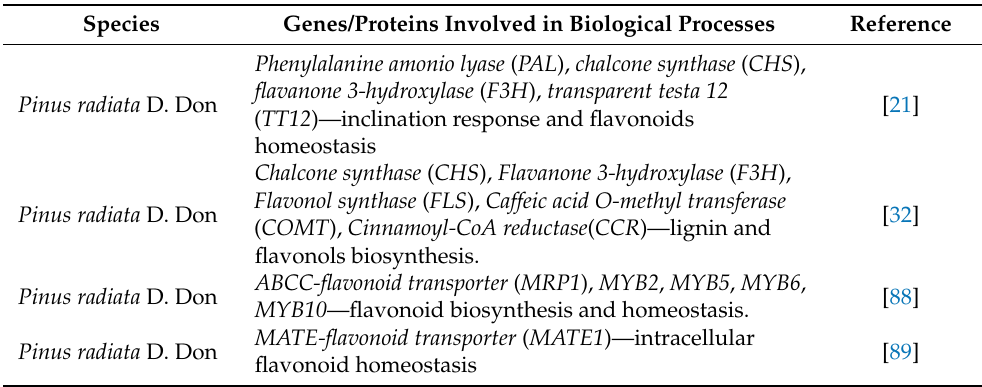
Table 3. Summary of genes and transporters involved in flavonoids homeostasis modulated in response to inclination in gymnosperm species. Species Genes/Proteins Involved in Biological Processes